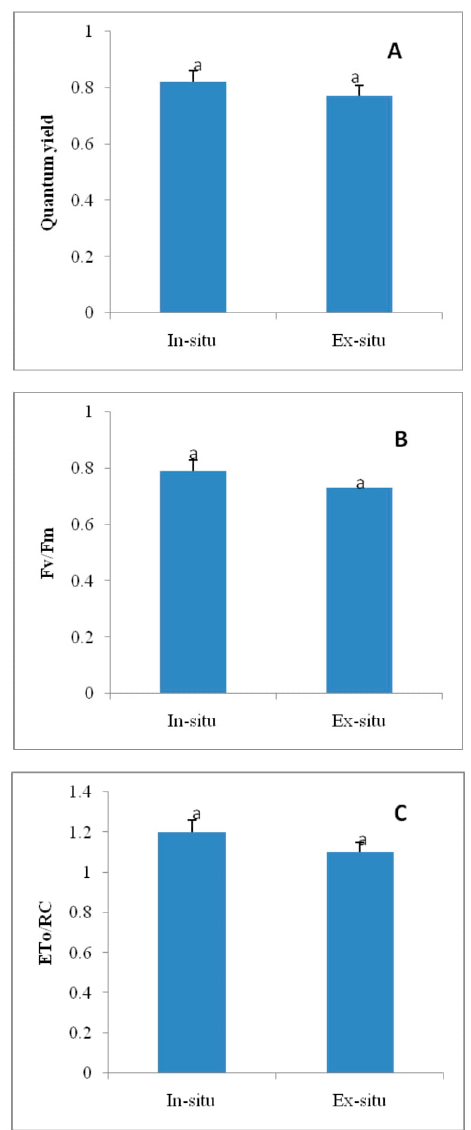
Figure 4. Quantum yield ( Φ PSII ) ( A ), chlorophyll fluorescence Fv/Fm ( B ), and reaction centre ETR (ETo/RC; electron transport flux per active reaction center) (C) in in-situ and ex-situ grown plants of Valeriana wallichii. Data are presented as treatments mean ± SE ( n = 5). SE = standard error; n = number of samples. The mean difference of in-situ from ex-situ was considered statistically significant at p < 0.05 (using Student’s t -test). Data followed by the same letter are not significantly different.